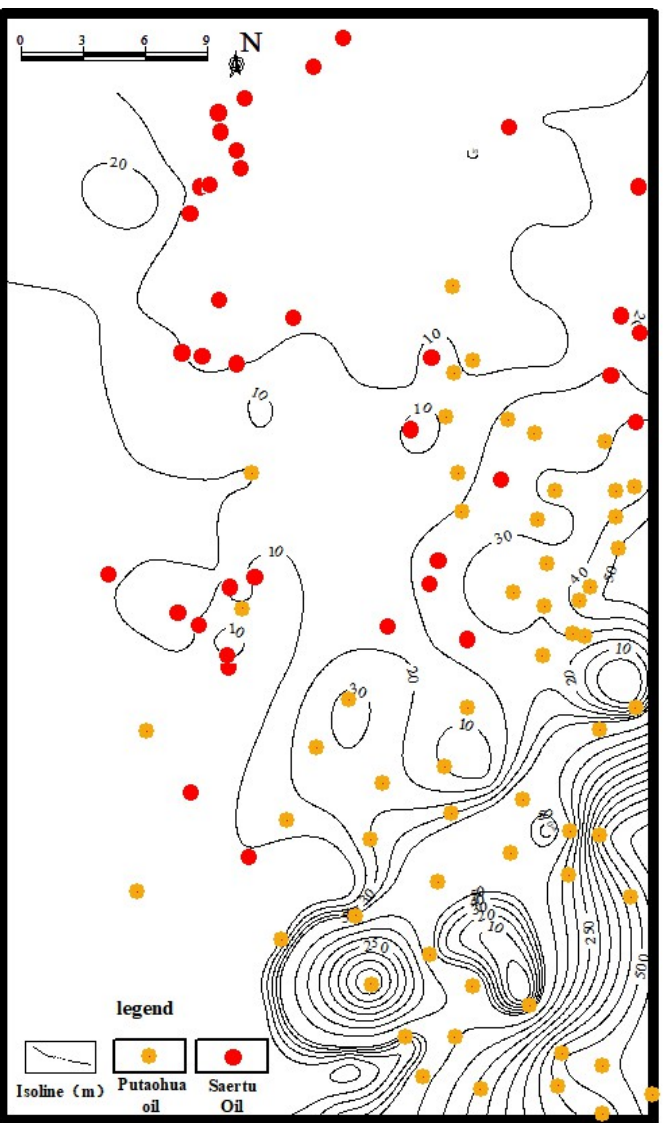
Figure 4. Thickness distribution map of the Sapu mudstone barrier in the Bayan Chagan Area. Three-dimensional seismic data interpretation identifies three types of faults, including source-connected faults, channels, and barriers at the Sapu cap rocks in the Bayan Chagan Area (Figure 5). However, not all of them can act as a pathway for Putaohua hydrocarbon fluid migrating to the overlying Saertu reservoir and Heidimiao reservoir. Only source- connected faults that were opened during oil charging (cutting T02 and T2 reflectors or overlapping other source-connected faults) could act as channels. Figure 6 shows that channels are well developed in the whole Bayan Chagan Area except the northwest, extending along the NS